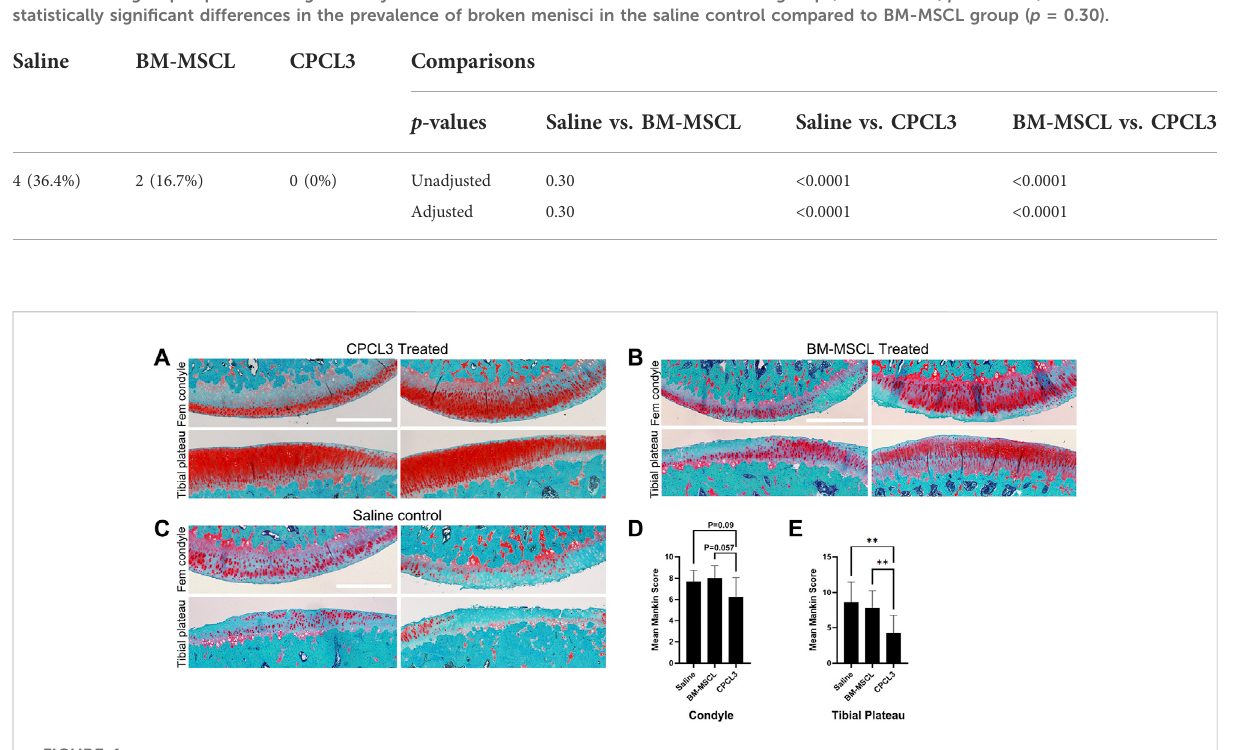
FIGURE 4 Animals with meniscus tears that weretreated byintra-articular injection of CPCL3 exhibitreduced post-traumatic cartilage degeneration. The knee articular cartilage from the medial compartment of each knee that was subjected to a medial meniscus injury were sectioned and stained with SafraninO/FastGreentovisualizetheextentofcartilageerosion.Stainingofthemedialfemoralcondylesandtibialplateausof (A) CPCL3-treated, (B) BM-MSCL-treated, and (C) vehicle alone treated animals are shown. Both BM-MSCL-treated and vehicle alone treated animals show severe proteoglycanloss,indicatedbydiminishedredstainingincomparisontoCPCL3-treatedanimals.Scalebarsrepresent500 µm. (D) Averagemodi fi ed Mankinscoringresultsofmedialfemoralcondylesand (E) medialtibialplateausofeachexperimentalgroupareshown.N ≥ 8pertreatmentgroup.**, p ≤